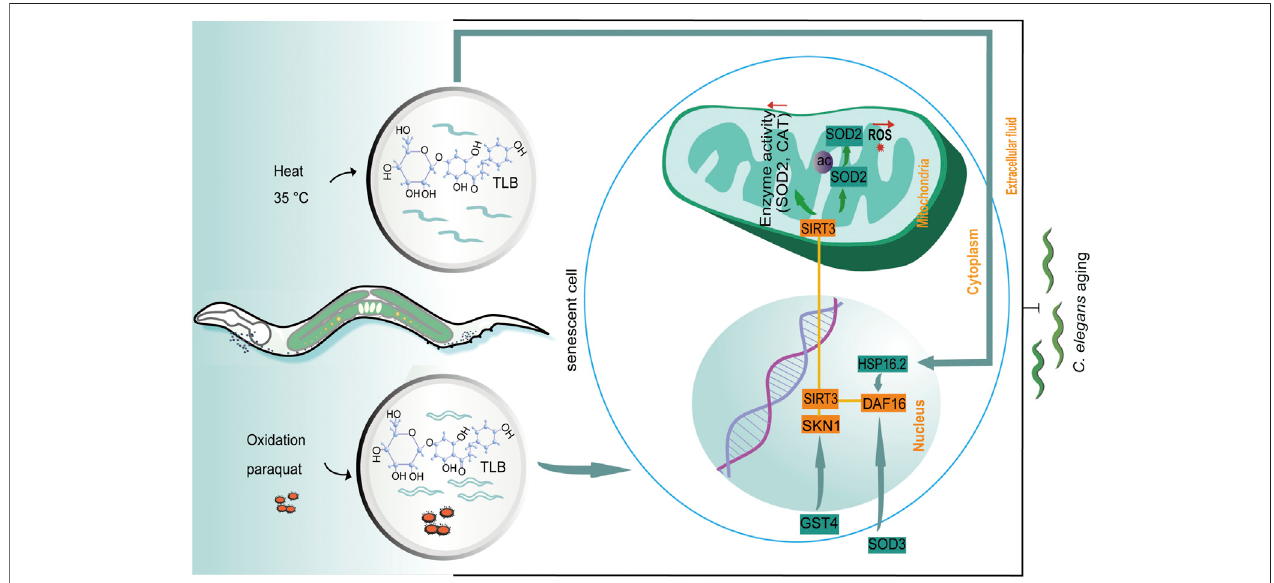
FIGURE 10 | The schematic presentation illuminating proposed mechanisms that TLB prolonged lifespan in C. elegans . Excessive ROS production is caused by paraquat and 35 ° C leading to aging in C. elegans . TLB attenuates overproduction of ROS and improves the anti-oxidative ability through mediating the SKN1/SIRT3/ DAF16 axis.